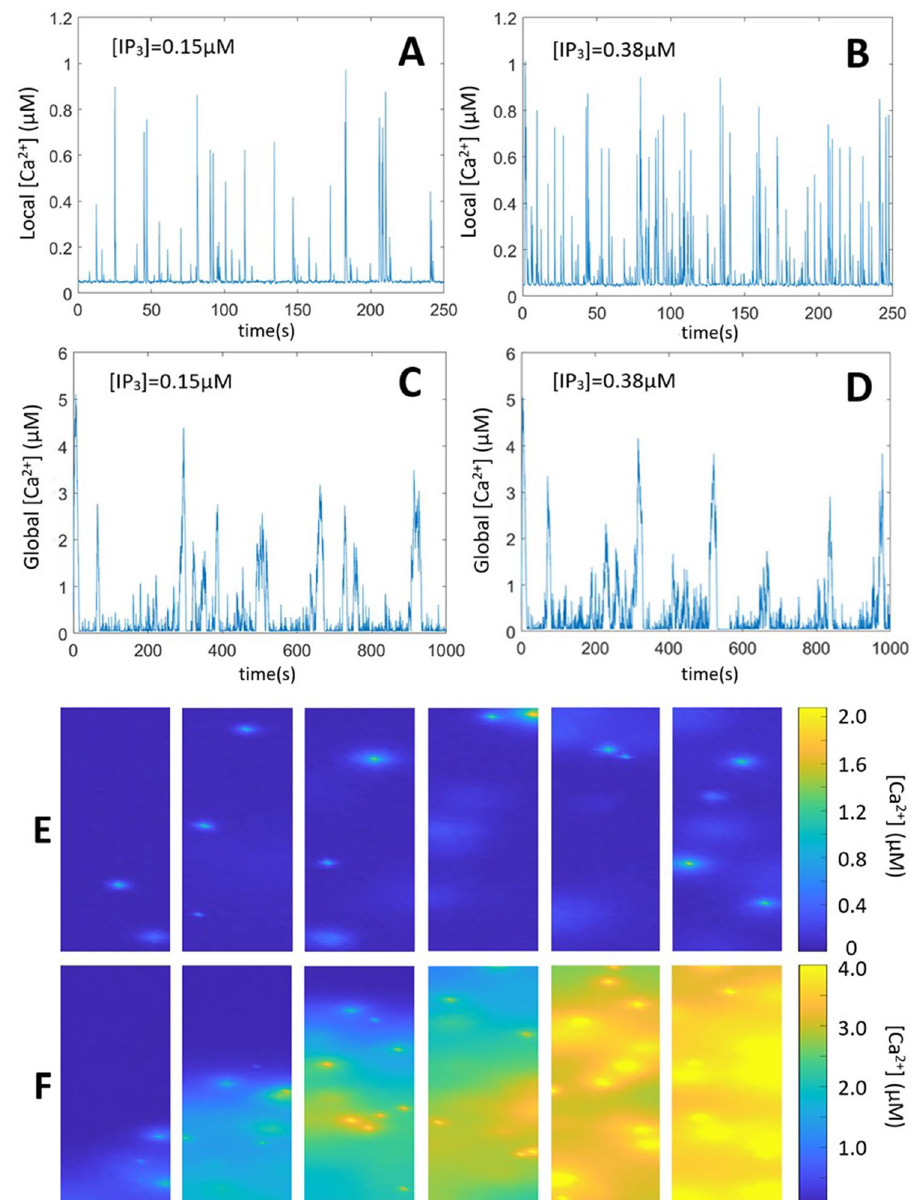
Figure 2. Stochastic simulations of Ca 2+ puffs and spikes. ( A and B) show the evolution of Ca 2+ concentration in a 1 fL volume (1.5 × 1.5 μm 2 in the 2D simulations, see Voorsluijs et al. 9 ) centered around the cluster at two [IP 3 ]. For the 2 panels, one cluster, located at the centre of a 5 × 5 μm 2 2D system is considered. For panels ( C and D) , a larger 5 × 10 μm 2 system containing 10 clusters is simulated. All values of parameters are the same as in A and B and listed in Table S2. Time series show the evolution of Ca 2+ concentration averaged on the whole system. Panels ( E and F) show the spatio-temporal evolutions of Ca 2+ puffs and spikes, respectively. In the two cases, the system is 50 × 10 μm 2 large and 10% of the total surface is occupied by clusters (200 clusters). For panel E, [IP 3 ] is constant and equal to 0.075 μM everywhere in the cell. For panel F, IP 3 was released in one spot (with dimensions 0.5 × 0.5 μm 2 ) located in the bottom center of the simulated cell. For panels E and F, times corresponding to each subpanels are: 0.1, 0.6, 2.5, 3.4 and 5.2 s after the increase in [IP 3 ] from 10 nM. In panels A-E, [IP 3 ] is increased at time 0, and Eqs. (3) and (5) are not considered. In panel F, the release of IP 3 is simulated using Eq. (3), with θ = 1000µMs −1 , D I = 100 μm 2 s −1 and t ph = 500